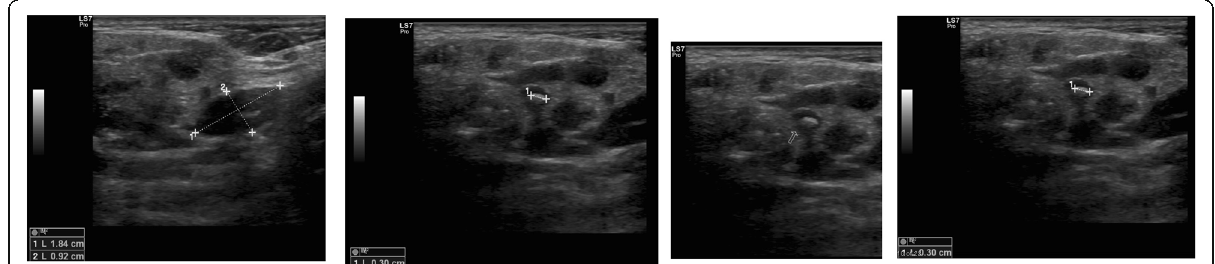
Fig. 1 Ultrasonography showed homogeneous echo pattern with mild dilatation of the left Stensen ’ s